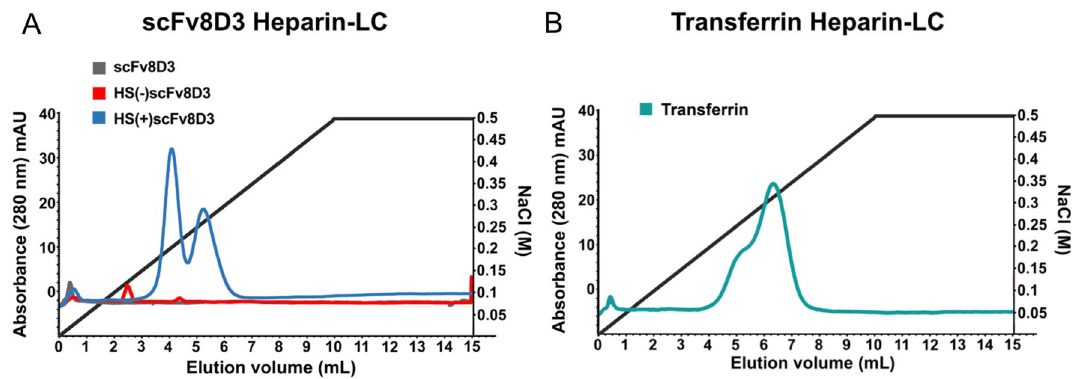
Figure 4. HS binding capacity determined by heparin column chromatography. Heparin binding strength was analysed by heparin affinity LC with gradient NaCl elution (black line). The absorbance was monitored at 280 (nM). ( A ) The HS(+)scFv8D3 mutant (blue) binds to heparin and has one peak at 0.20 M NaCl and second peak at approximately 0.25 M NaCl. The scFv8D3 is shown in grey and the HS(−)scFv8D3 mutant is shown in red. ( B ) Transferrin (teal line) binds to heparin and has an elution peak at approximately 0.25–0.30 M